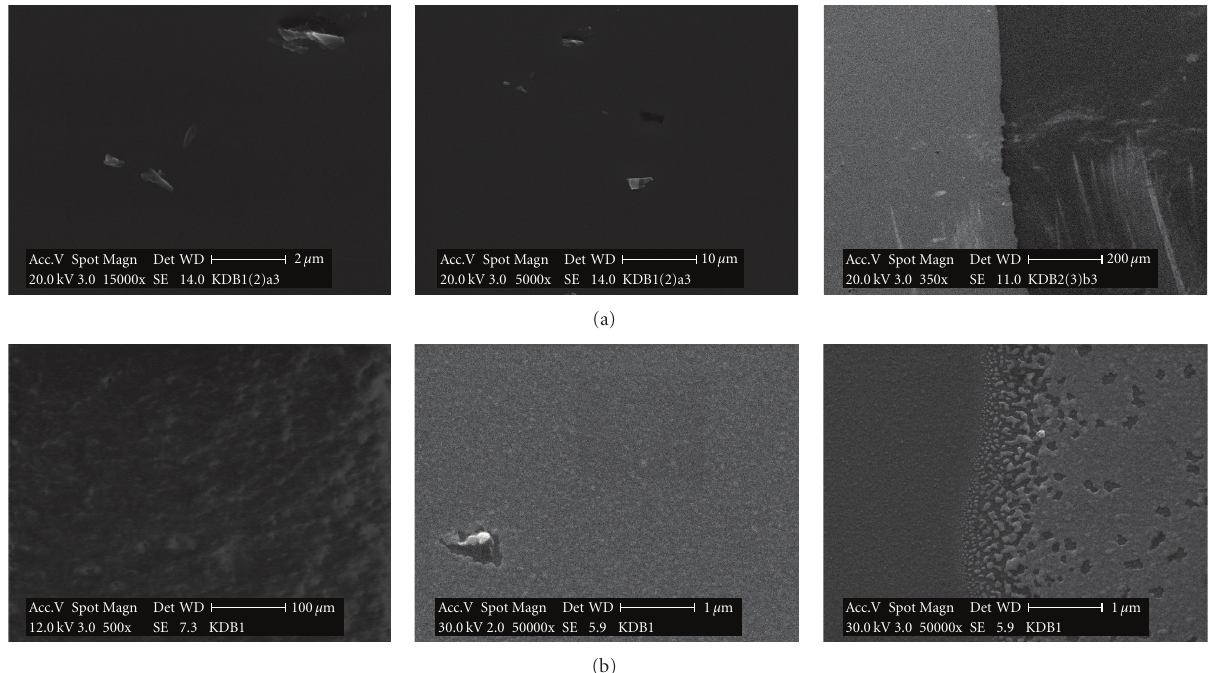
Figure 3: HRSEM images for a series of samples with titanium top layers and the boarder between titanium and palladium for samples partially covered by Pd before (a) and after (b) hydrogen